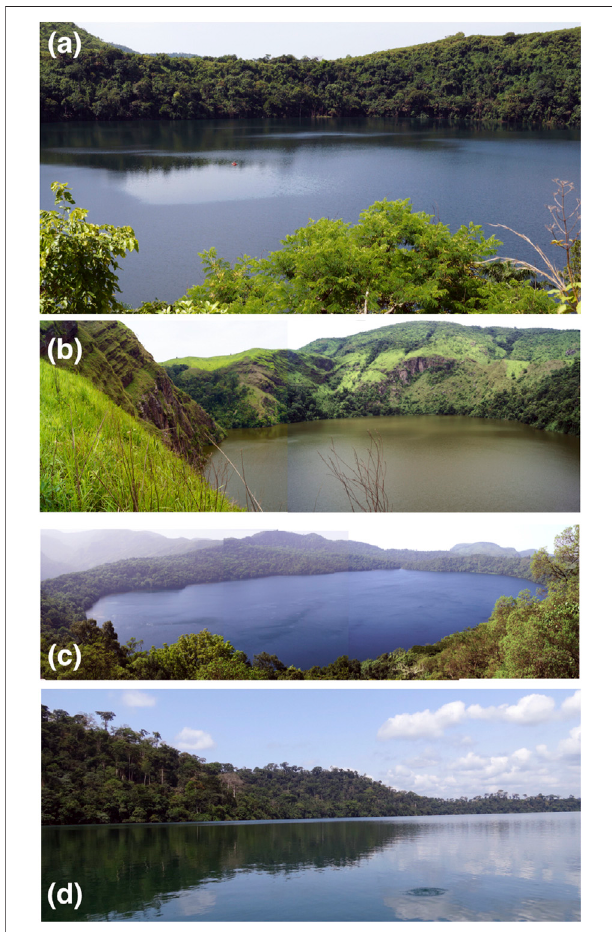
FIGURE 4 | Views of the Cameroonian maar lakes (A) Elum, (B) Enep, (C) Oku and (D) Barombi Mbo (pictures (A – C) by Issa, picture (D) by